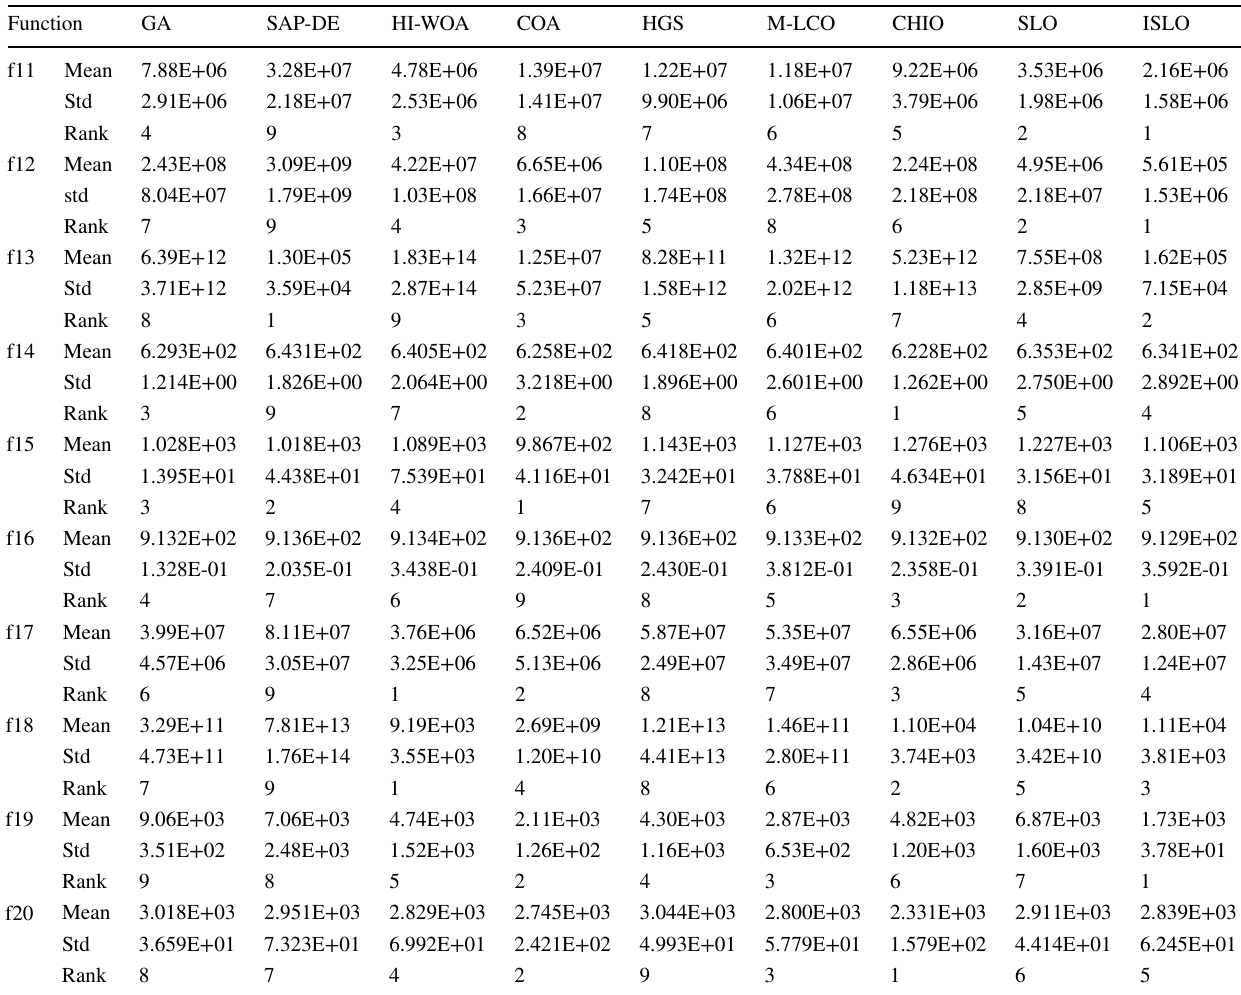
Table 3 Comparison of the optimization results obtained for hybrid functions (f11–f15) and composition functions (f16–f20)